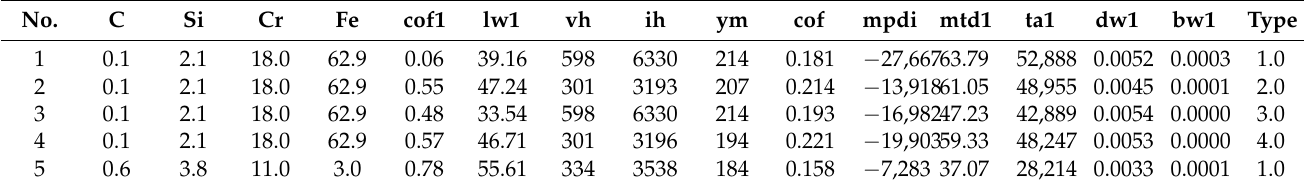
Table 4. Five elements of the set for dry friction with the added means.